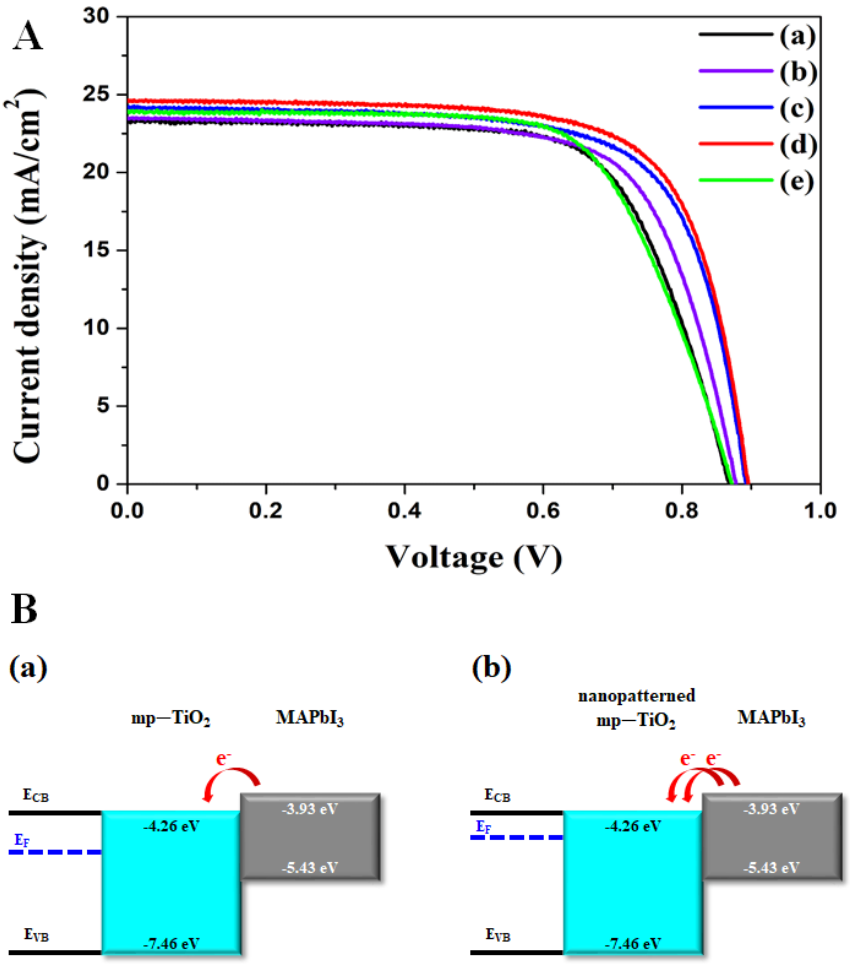
Figure 8. ( A ) shows the I-V characteristics of perovskite solar cells with and without a nanopat- terned mp-TiO 2 thin-film layer. A shows ( a ) non-nanopatterned perovskite solar cells and perovskite solar cells with a nanopatterned mp-TiO 2 thin-film layer with the depths of ( b ) 75 nm, ( c ) 97 nm, ( d ) 127 nm, and ( e ) 167 nm. ( B ) shows the electron equilibration of the apparent Fermi level on the nanopatterned mp-TiO 2 thin-film layer. ( a ) denotes the non-nanopatterned mp-TiO 2 thin-film layer, and ( b ) denotes the nanopatterned mp-TiO 2 thin-film layer. Table 1. Photovoltaic properties of perovskite solar cells with and without a nanopatterned mp- TiO 2 thin-film layer.